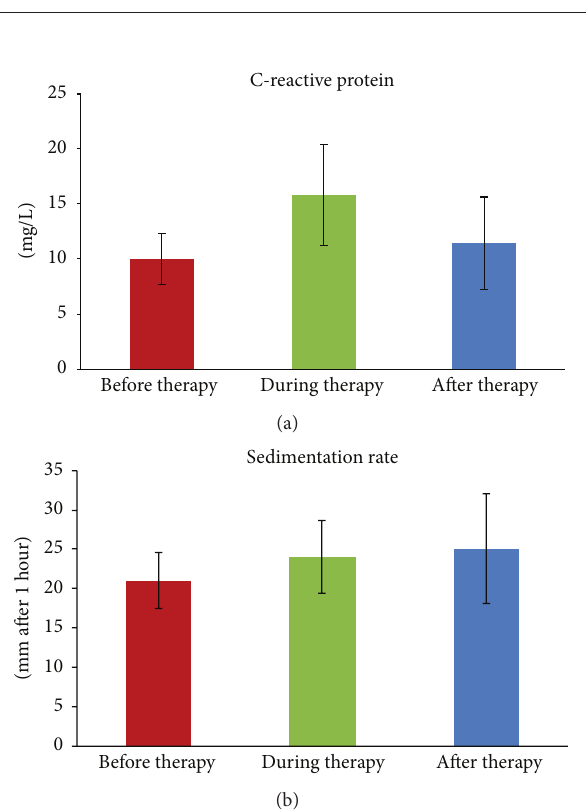
Figure 4: Mean level of inflammatory markers ( ± SD). (a) CRP. (b) Sedimentation rate in patients’ peripheral blood before ( 𝑛 = 39 ), during ( 𝑛 = 28 ), and after ( 𝑛 = 15 )